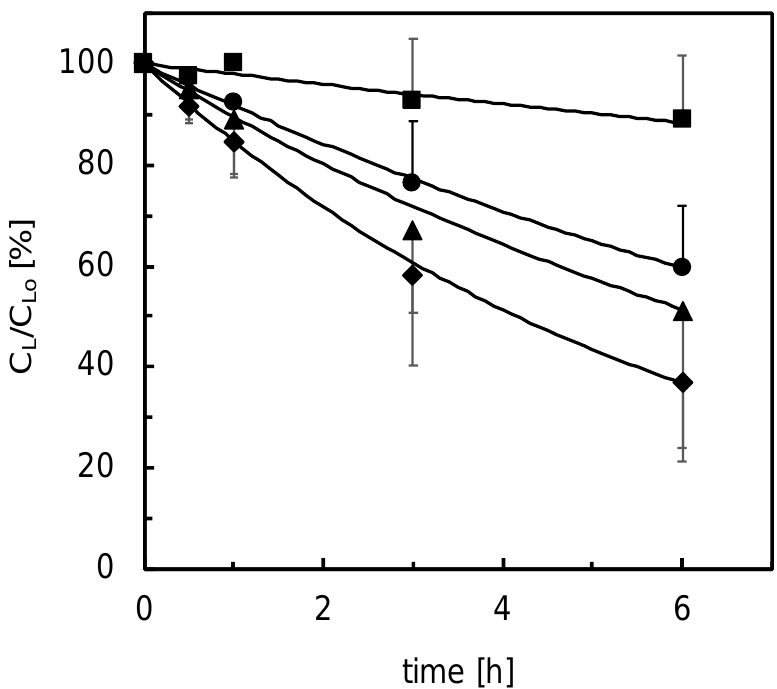
Figure 4. Lidocaine elimination during kinetic tests with adhesion cultures ( n = 3) at various days of culture: ( (cid:7) ) day 2; ( (cid:78) ) day 3; ( • ) day 5; ( (cid:4) ) day 14. Lines are model predictions.